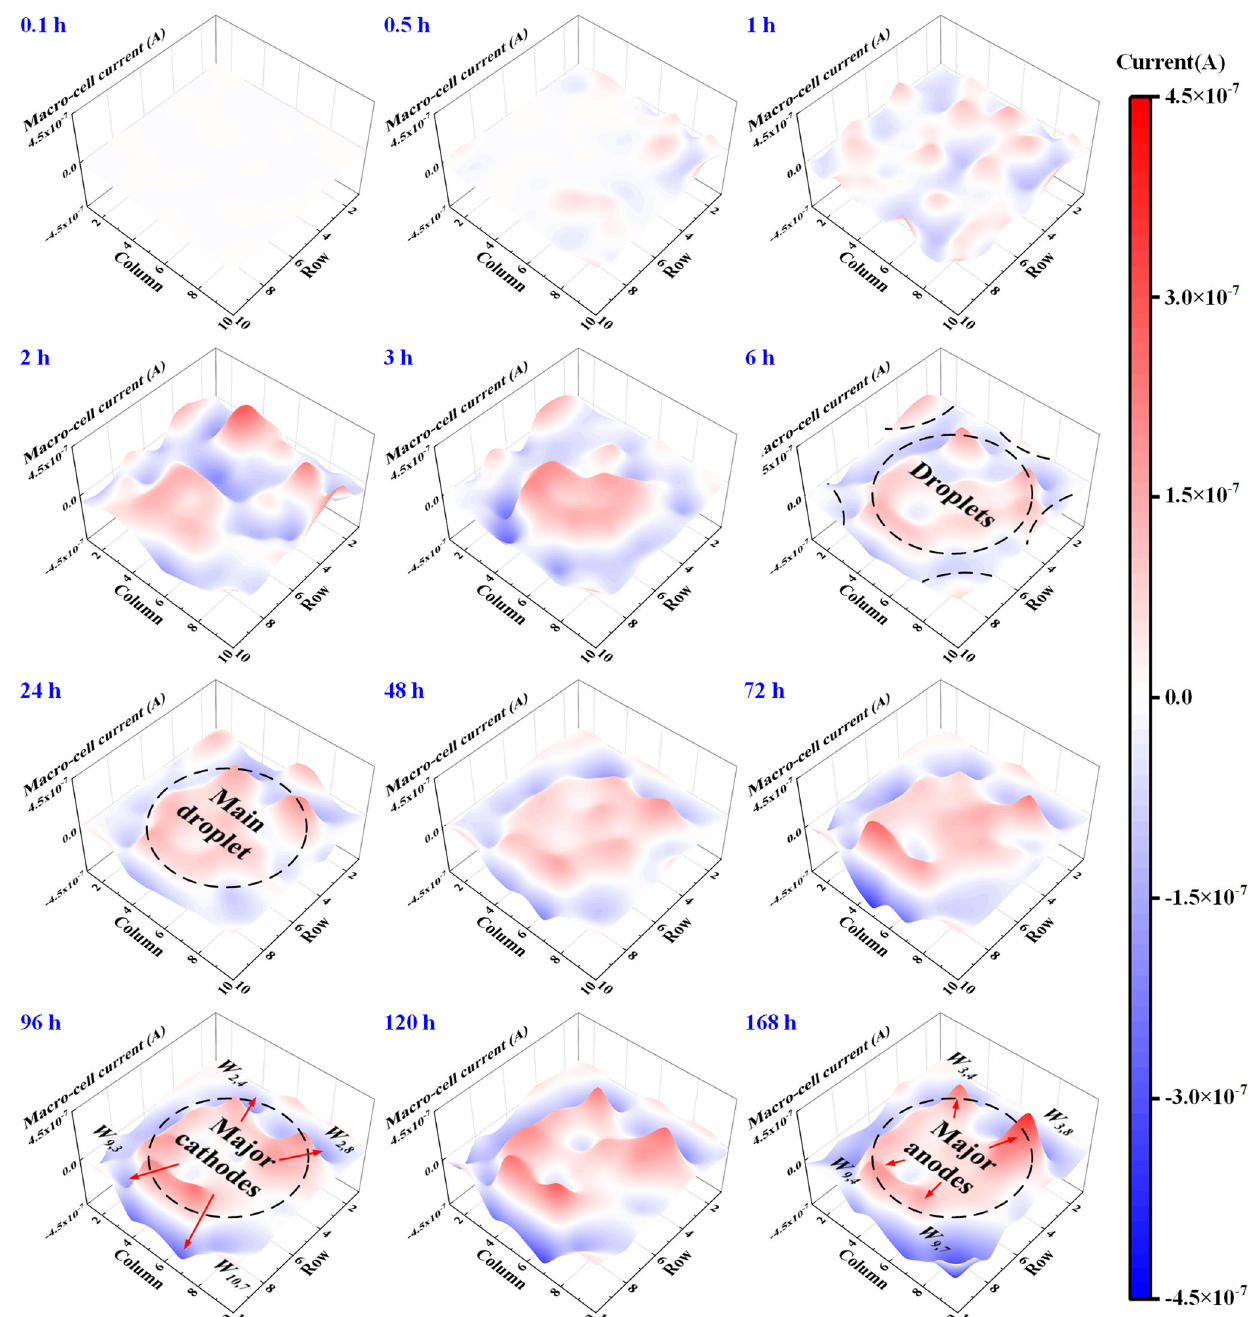
Fig. 2 The macro-cell current distribution maps. The distribution of the macro-cell currents on the WBE at different test